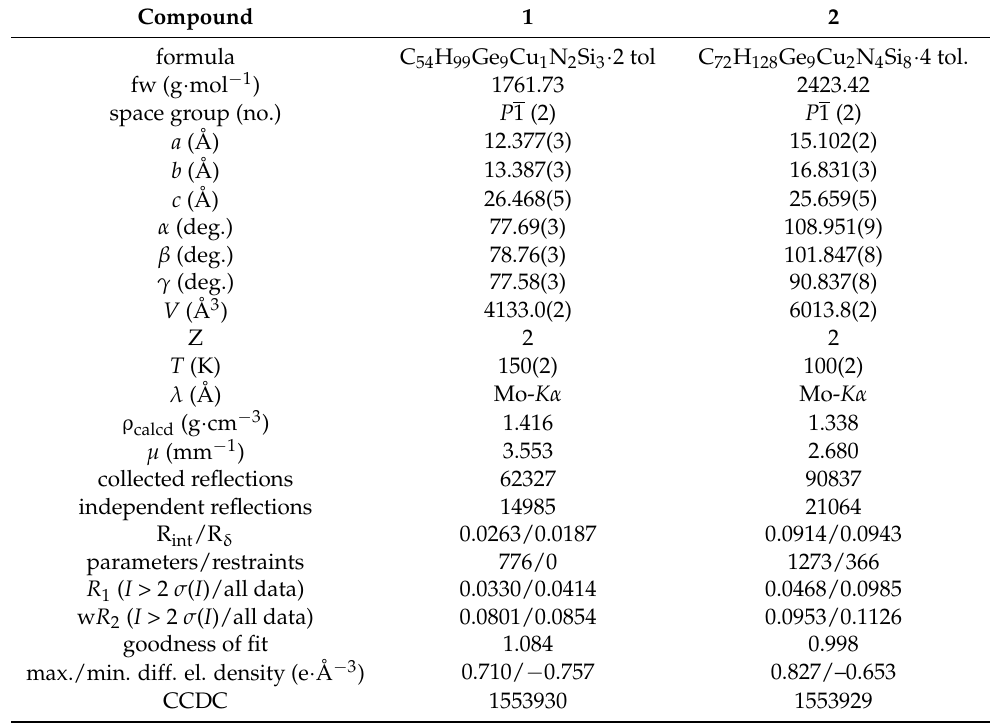
Table 3. Crystallographic data for compounds 1 and 2